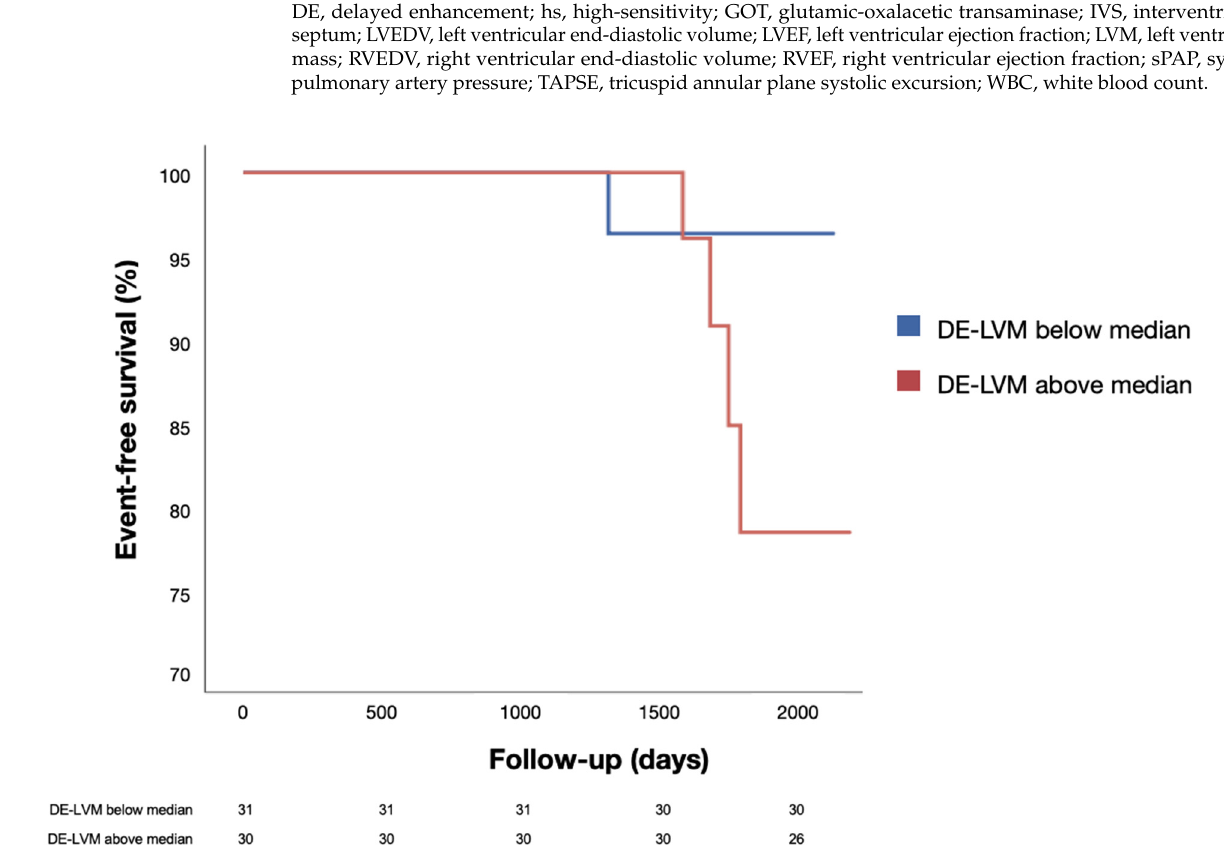
Figure 3. Kaplan–Meier survival curves for patients with left ventricular mass with delayed enhancement above (red) or below (blue) median. Numbers at risk are reported in lower part. DE, delayed enhancement; LVM, left ventricular mass.